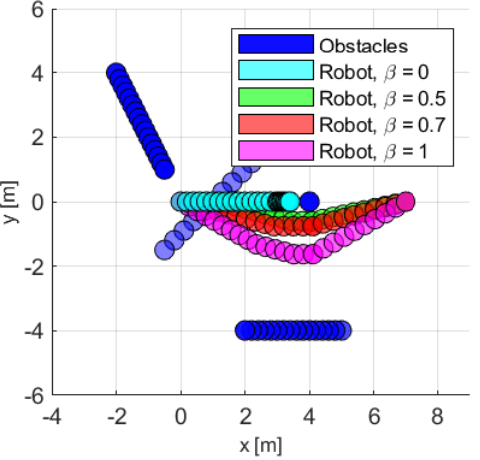
= ( 0m,0m ) T ) and obstacles Figure 11. The successive locations of the robot (starting from p A outlining the paths taken by them during the scenario. Blue: obstacles ( B 1 is a static obstacle at = ( 4m,0m ) T . B ( − 2m,4m ) T to ( − 0.5m,1m ) T . B ( 4m,3m ) T to p 2 moves from 3 moves from B1 ( − 0.7m, − 1.45m ) T . B ( 5m, − 4m ) T to ( 2m, − 4m ) T .). Cyan: the robot using VO with the 4 moves from TG heuristic. Green: the robot using VO with the MV heuristic, identical with GAVO using β = 1. Red: the robot using GAVO with β = 0.7. Magenta: robot using GAVO with β = 0. The target position is p g = ( 9m,0m ) T